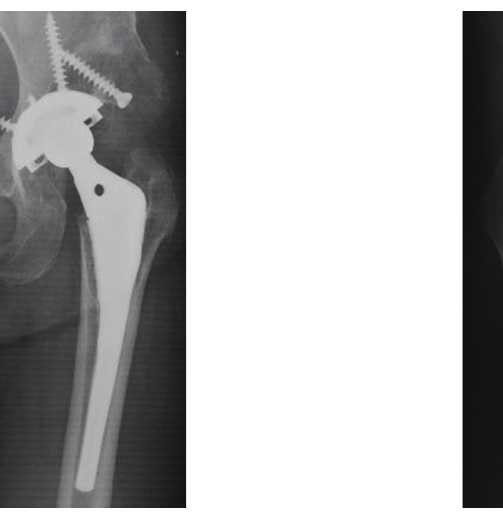
Figure 3: The AP radiograph of the left hip at 15 years after THA. The biological fixation of the stem was bone ingrown fixation.